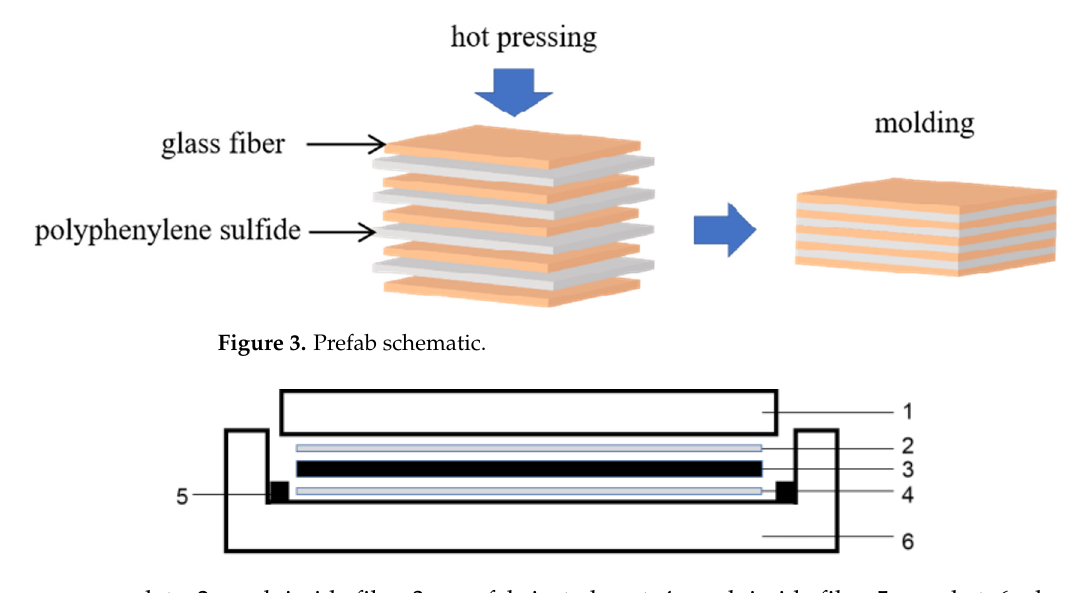
Table 2. Experimental parameters for composite preparation.